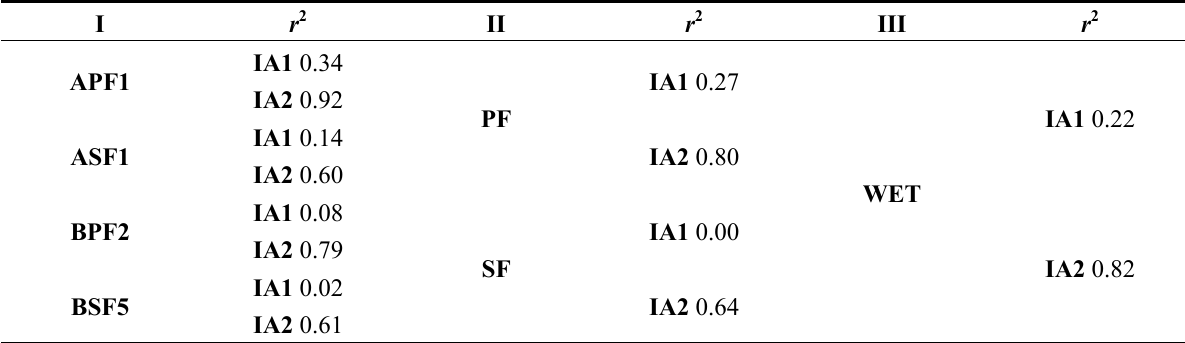
Table 5. Regression adjustments for Δ -Index cross polarization ratio (HV/HH) and surface